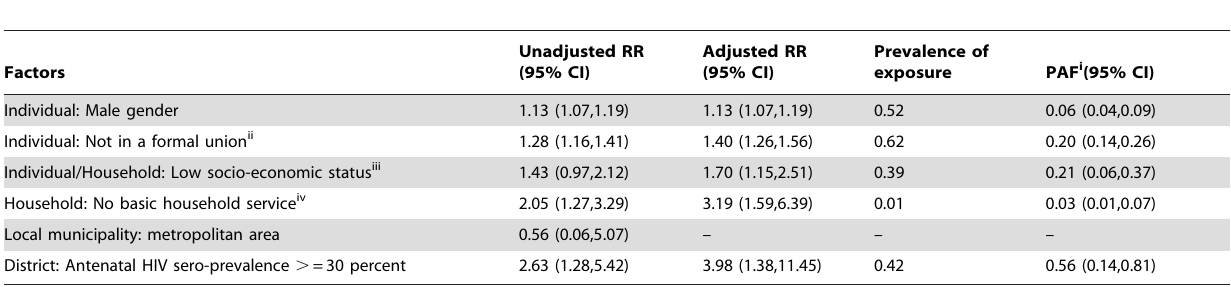
Table 3. Example of a targetable framework of modifiable determinants for high risk adult mortality areas using a multivariable Poisson ecological approach and including population attributable fractions, South Africa, 2007.